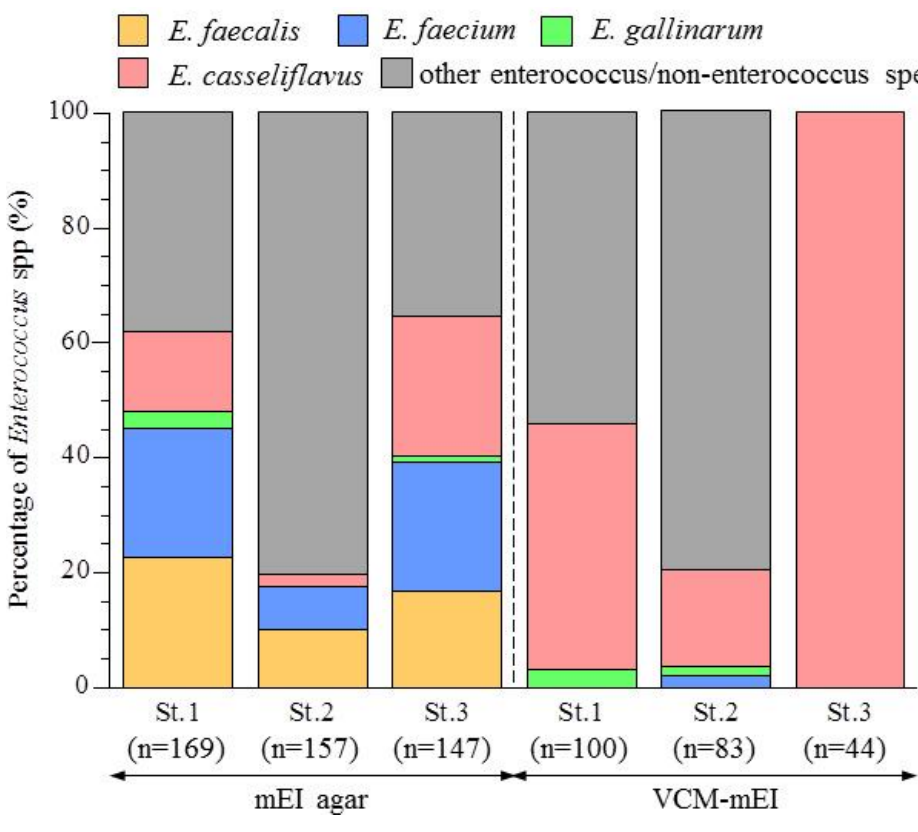
Figure 3. Diversity of Enterococcus species composition in Yae River.